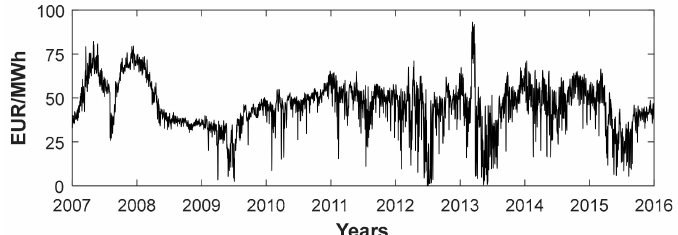
Figure 4. Electricity price distribution for the Iberian Peninsula for the 2007–2016 period (source: